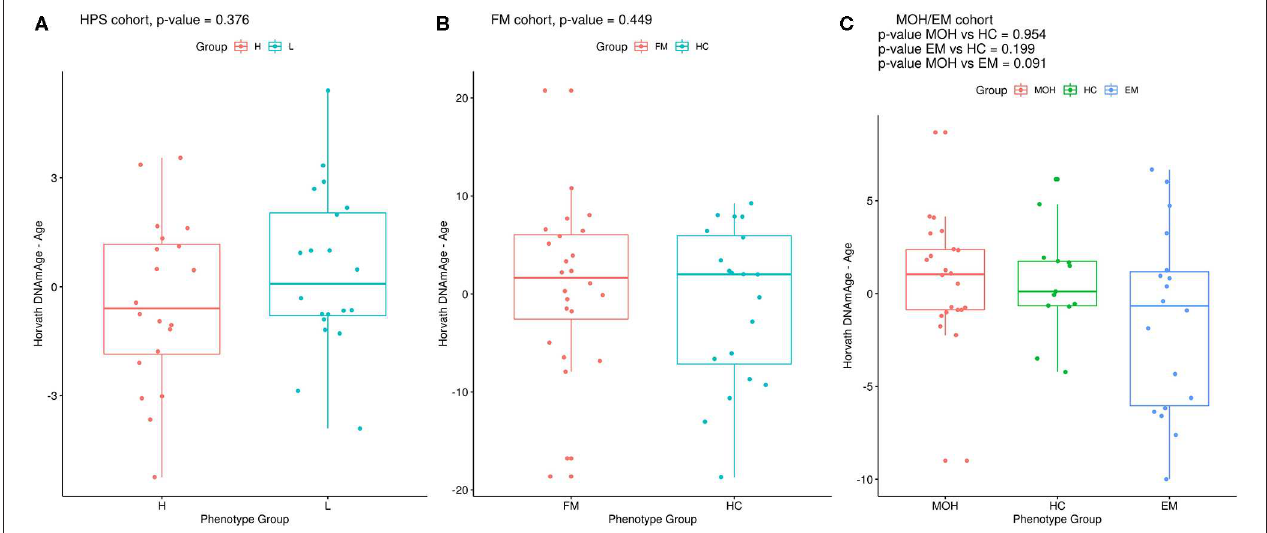
FIGURE 1 | Epigenetic age difference (Horvath’s DNAmAge – chronological age) adjusted for chronological age in the phenotypic groups in (A) HPS, (B) FM, and (C) MOH/EM cohorts. Reported p- values are from MLR analysis, as described in the Materials and Methods section.